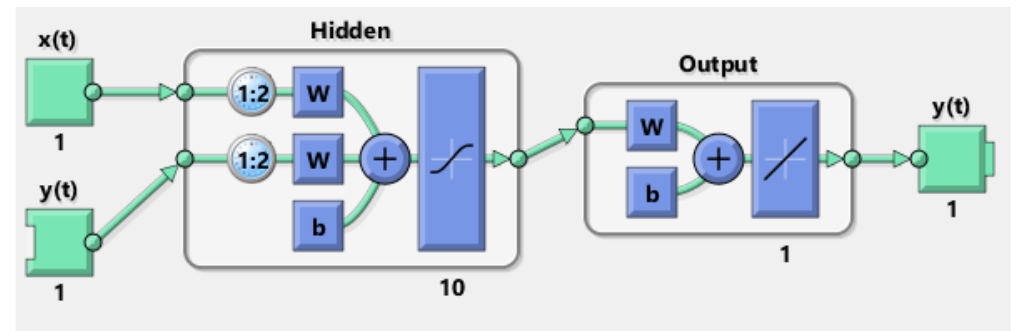
Figure 5. Integration of historical data and experts judgements in ARX, external variable.